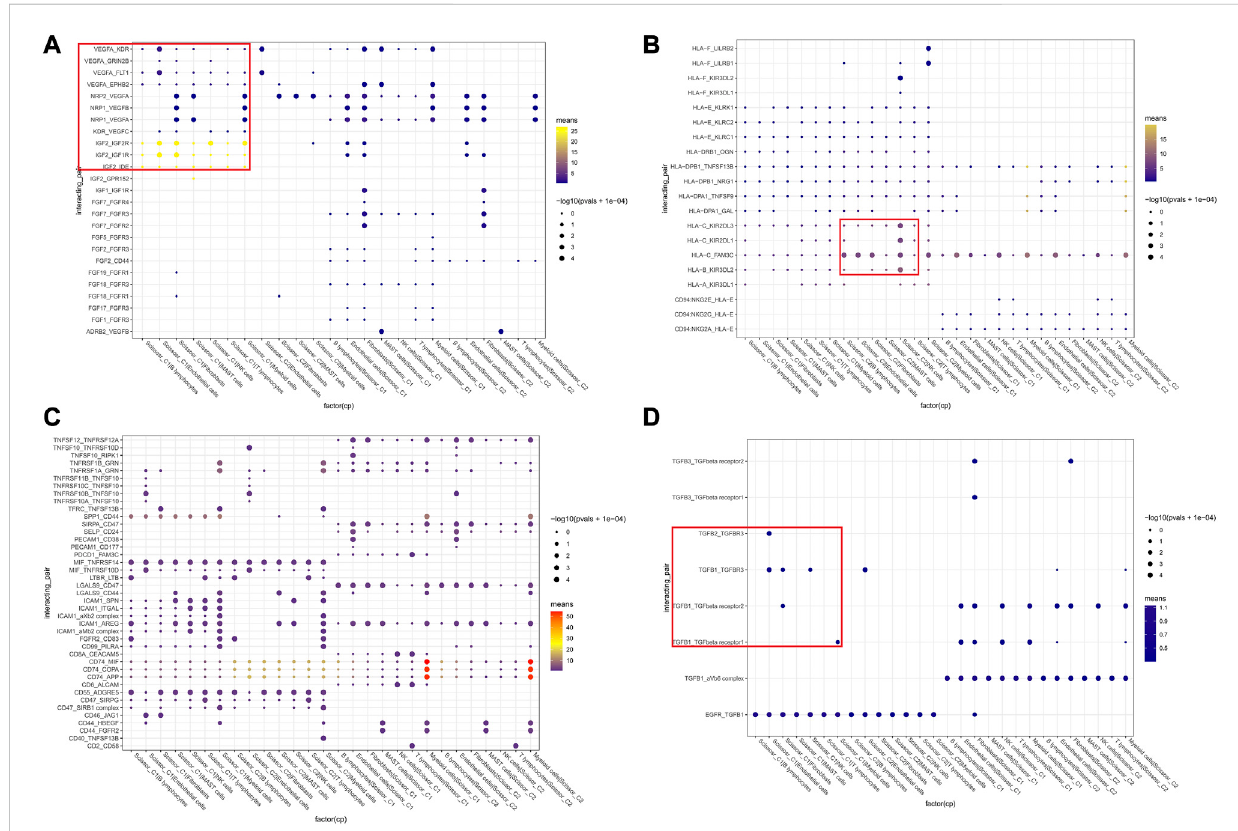
FIGURE 6 CellularcommunicationnetworksoftwogroupsofScissorcells (A) CommunicationbetweenScissorcellsandimmune,stromalcellgrowthfactors. (B) Communication between Scissor cells and MHC-like molecules of immune, stromal cells. (C) Communication between Scissor cells and immune, stromal cell colony-stimulating factors (D) TGF β analysis and cell growth factor